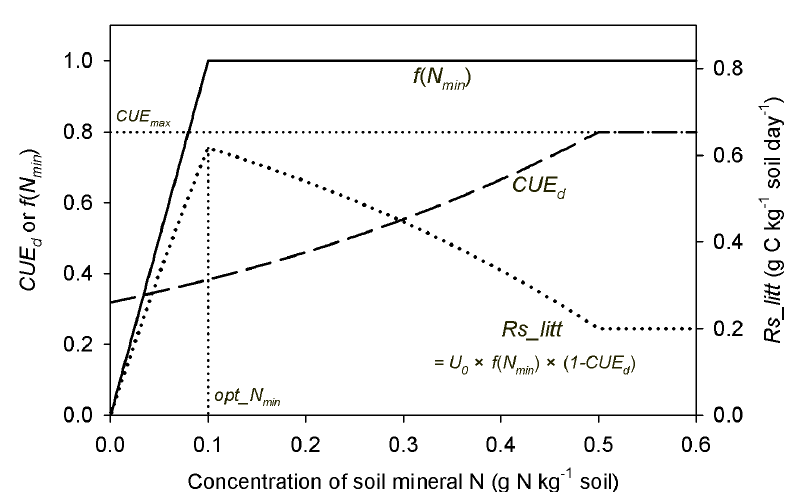
Figure A5. Schematic plot for change trends of f ( N min ) (inhibition effect of mineral N; Eq. 6), CUE d (carbon use efficiency of decomposed litter; Eqs. 2, 3) and Rs_litt (litter respiration rate) with increasing concentration of soil mineral N. CUE max (equal to 0.8) is the maximum CUE set in this study. opt_N min denotes the concentration of soil mineral N at which litter respiration is maximized. U 0 is the potential decomposition rate when mineral N is fully adequate for litter